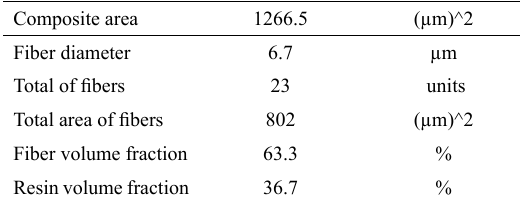
Figure 4. (a) SEM image of longitudinal direction of Sikacarbodur S512 material. (b) SEM cross-section image of Sikacarbodur S512 material. (c) SEM cross-section image of Sikacarbodur S512 material before tensile tests. (d) Typical SEM image of carbon fiber volume fraction. Table 3. Carbon fiber volume fraction of Sikacarbodur S512